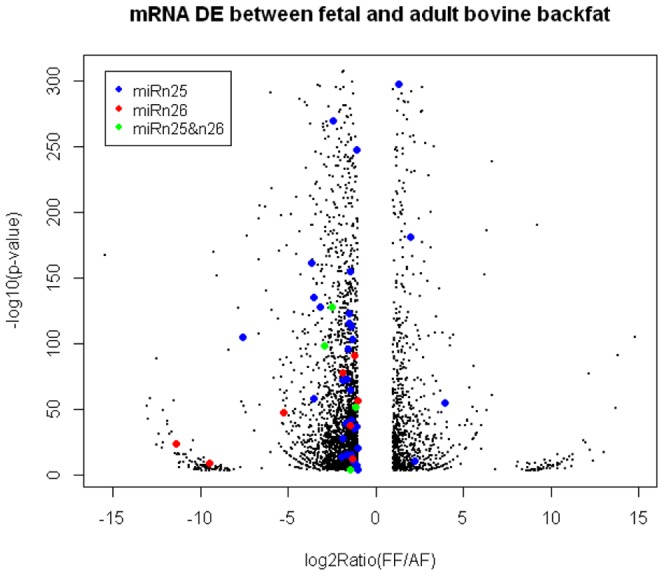
Gene expression plot between fetal and adult bovine backfat tissue were shown.Note: Each dots in the figure represents a gene. Green dots represent the target genes of bta-miRNAn25, red dots represent bta-miRNAn26, and blue dots represent bta-miRNAn45&48, respectively.